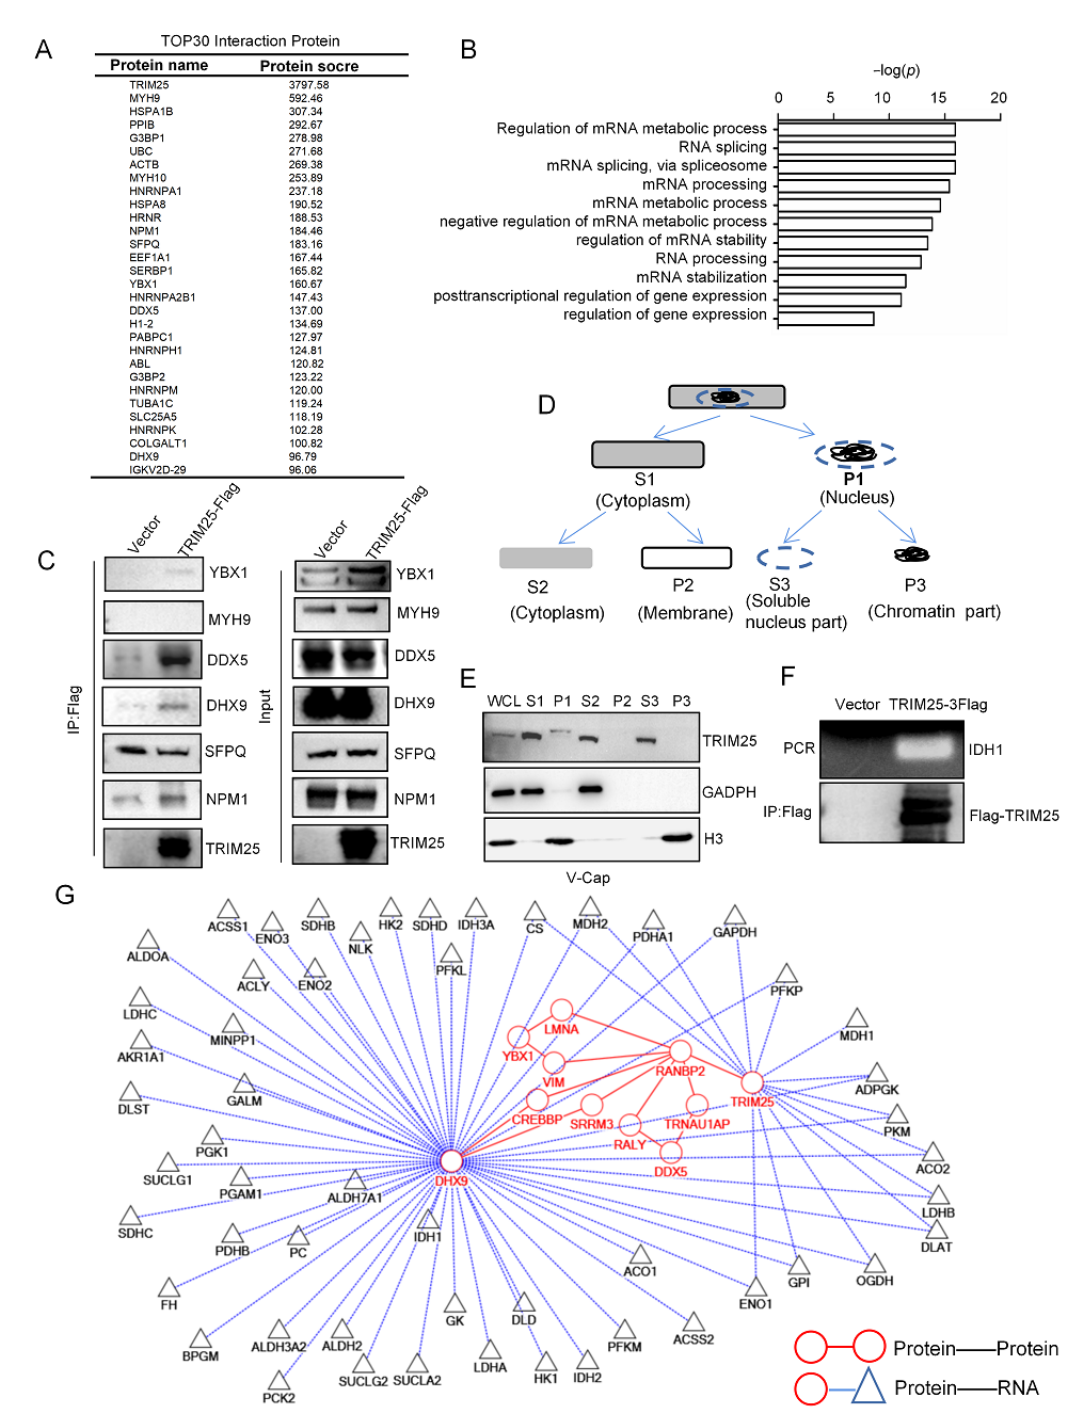
Figure 4. TRIM25 performs RNA processing functions. ( A ) Top 30 proteins based on protein scoring by LC-MS. ( B ) GO annotated TRIM25-interacting protein function. ( C ) Verification of TRIM25-interacting proteins by immunoprecipitation with Flag-M2 beads. ( D ) Flowchart of cell fractionation. ( E ) TRIM25 expression in various fractions of V-Cap cells. ( F ) RNA-Chip validated TRIM25 binding to RNA of IDH1. ( G ) The subnetwork of TRIM25 constructed by integrating the W-K-DN and the protein – RNA interactions.